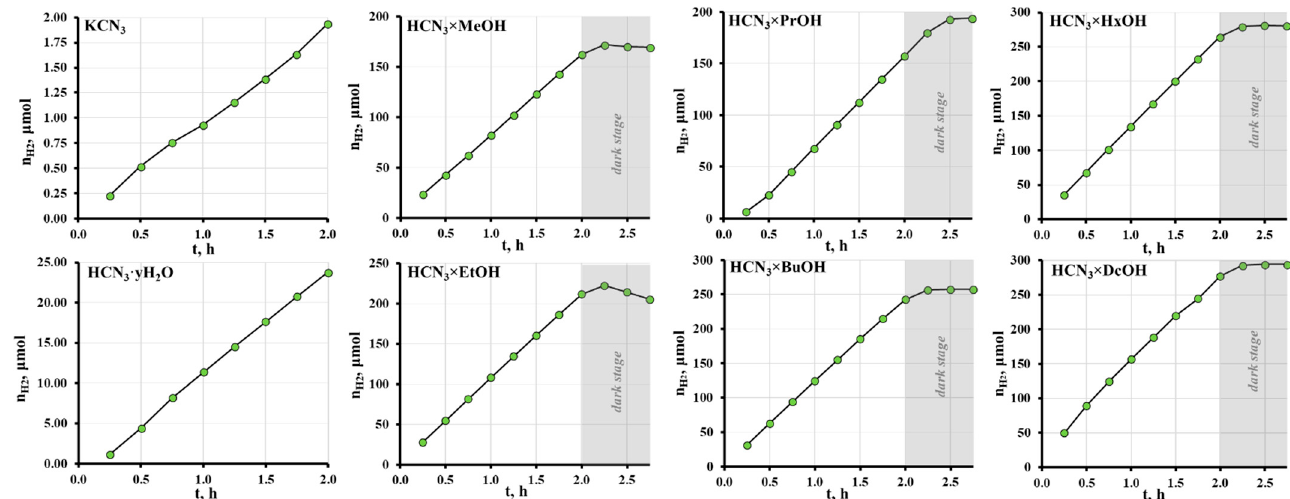
Figure 7. Kinetic curves of photocatalytic hydrogen generation over bare initial niobates and their n -alkoxy derivatives.